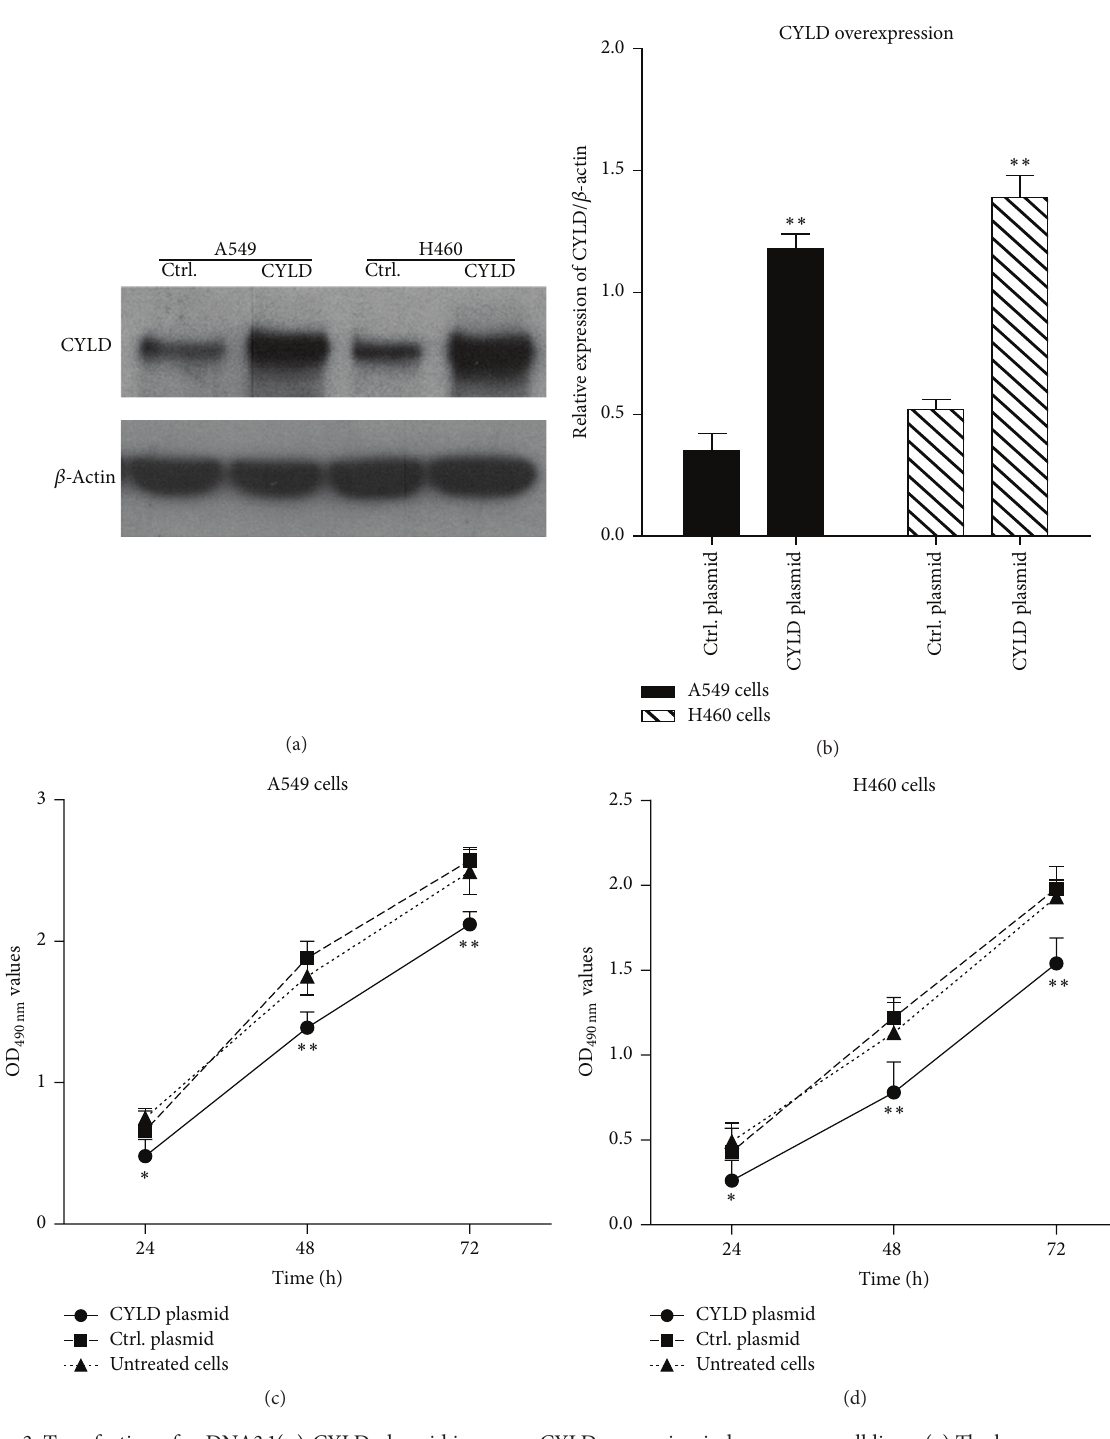
Figure 3: Transfection of pcDNA3.1(+)-CYLD plasmid increases CYLD expression in lung cancer cell lines. (a) The lung cancer cells A549 and H460 were transfected with the recombinated plasmid pcDNA3(+)/CYLD-flag and control plasmid pcDNA3.1(+) for 24 hours. The levels of CYLD were detected by western blotting analysis. (b) The images were captured by image J software and gray values were analyzed and shown in histogram. ∗∗ 𝑝 < 0.01 , compared with control plasmid. (c) A549 cells were transfected with CYLD-flag plasmid and cultured for 24 h, 48 h, and 72 h, respectively. The cell viability was determined by MTT assay. ∗ 𝑝 < 0.05 , ∗∗ 𝑝 < 0.01 , compared with the control plasmid transfected cells. (d) H460 cells were transfected with CYLD-flag plasmid for 24 h, 48 h, and 72 h. The cell viability was determined by MTT assay. ∗ 𝑝 < 0.05 , ∗∗ 𝑝 < 0.01 , compared with the control plasmid transfected